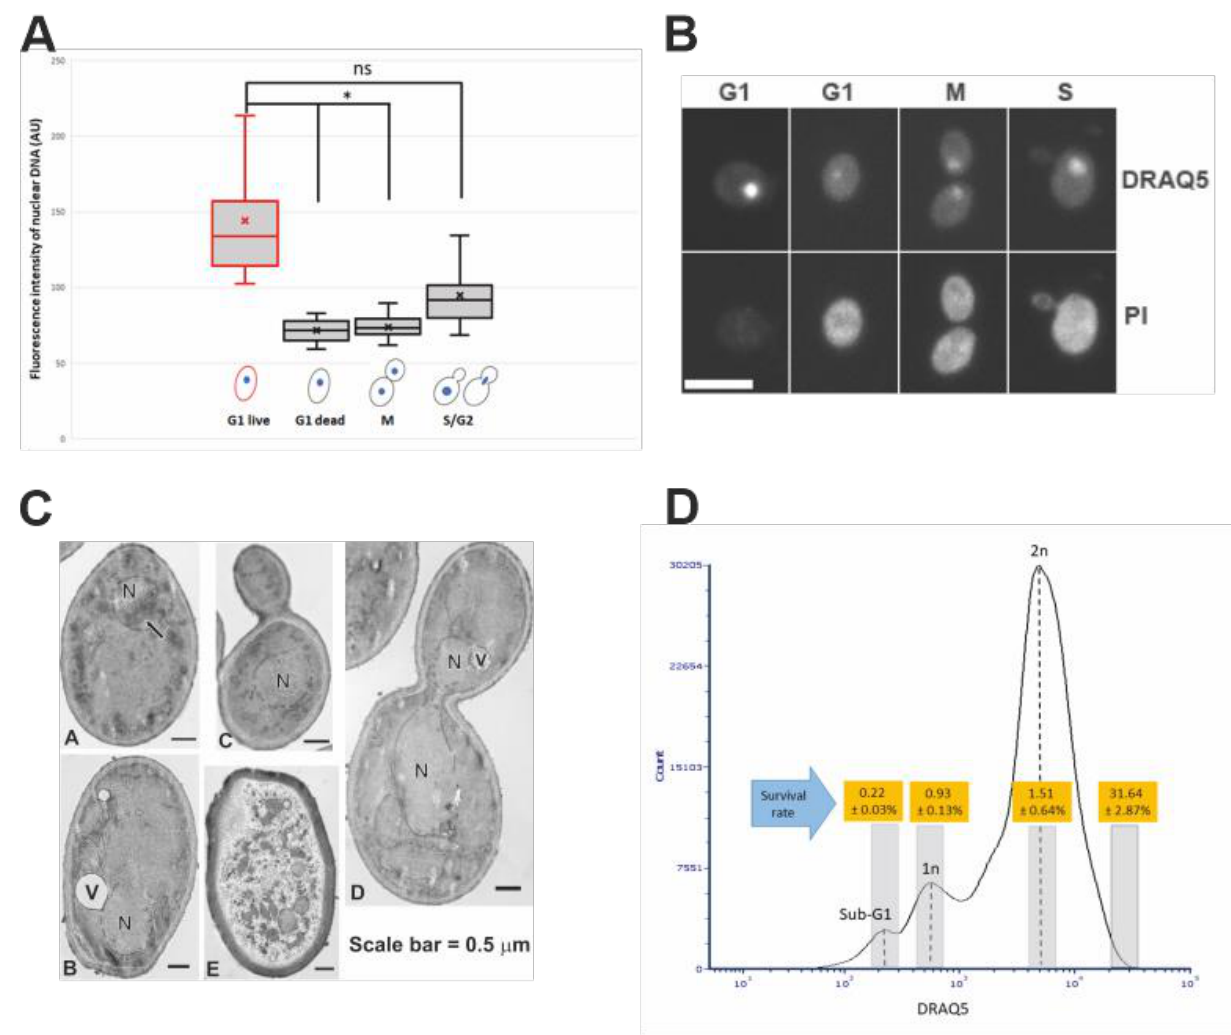
FIGURE 2: Chromosome condensation in desiccated G1 log-phase cells. (A) Measurement of DNA content of live/dead log-phase cells (after 14 days of desiccation) in different cell cycle phases. Approximately 400 cells were counted from each experiment and the data presented here are the sum of three independent experiments. *: p < 0.05; ns: not significant. (B) Representative confocal microscopy images of log- phase cells at different cell cycle stages after 14 days of desiccation, showing higher fluorescence intensity (indicated by DRAQ5 staining) in live G1 phase cells (indicated by negative PI staining). The dead G1, S and M phase cells (indicated by positive PI staining) had lower DNA fluorescence intensity (indicated by DRAQ5 staining). Scale bar = 5 µm. (C) Transmission electron microscopy images of log-phase cells after 14 days of desiccation (A); a G1 phase cell with condensed chromosome (arrow) (B); a G1 phase cell with no chromosome condensation (C); a S-phase cell with no chromosome condensation (D); a G2 phase cell with no chromosome condensation (E). a dead cell. N = nucleus, V = vacuole; (D) Cell sorting and cell viability of sorted log-phase cells after 14 days of desiccation. The histogram shows the flow cytometry analysis of the DRAQ5 stained log-phase cells. The grey bars on the histogram indicate cells that were sorted and tested for viability. Viability was tested by plating assay. Data were presented as mean ± standard error from three independent OPEN ACCESS | www.microbialcell.com 45 Microbial Cell | FEBRUARY 2022 | Vol. 9 No. 2